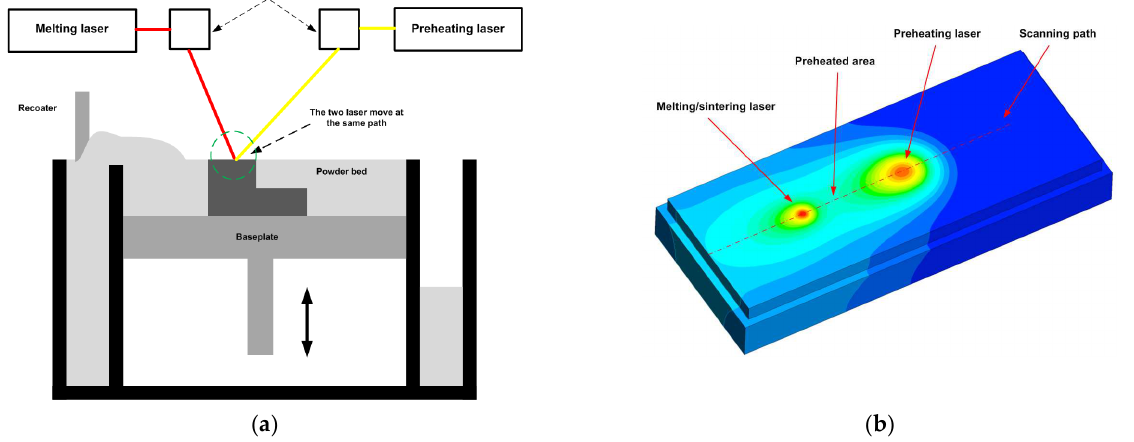
Figure 1. The preheating system developed in this study; ( a ) schematic diagram for the system, ( b ) simulation of the two lasers moving at the same scanning path.